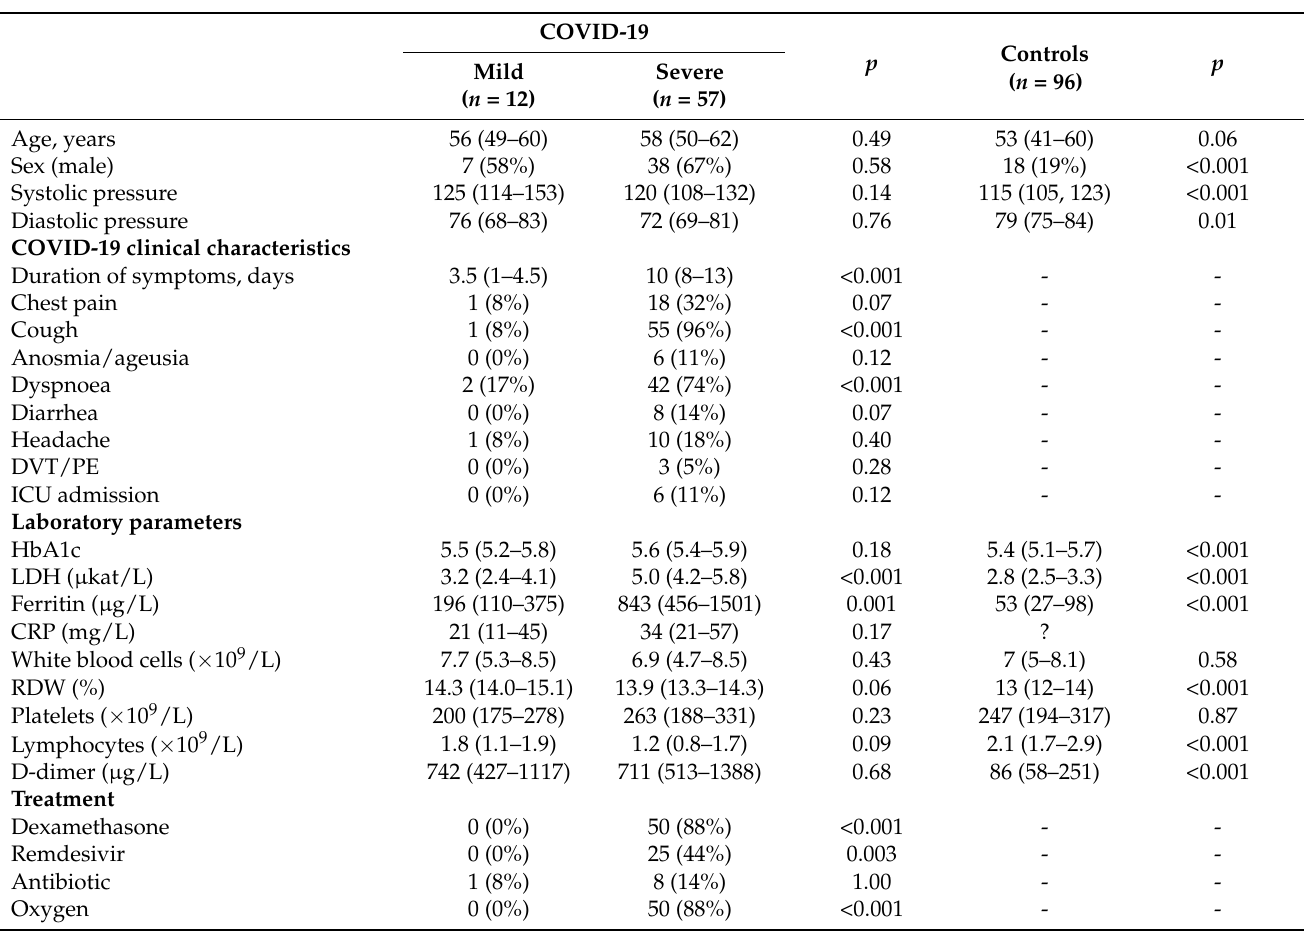
Table 1. Demographic and clinical characteristics of patients in the acute phase of COVID-19, compared with the control group.